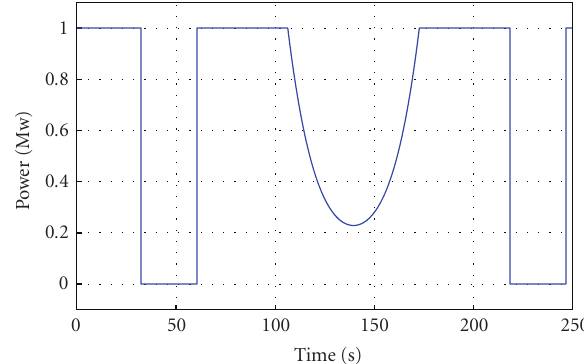
Figure 20: Per-unit wind turbine produced power.